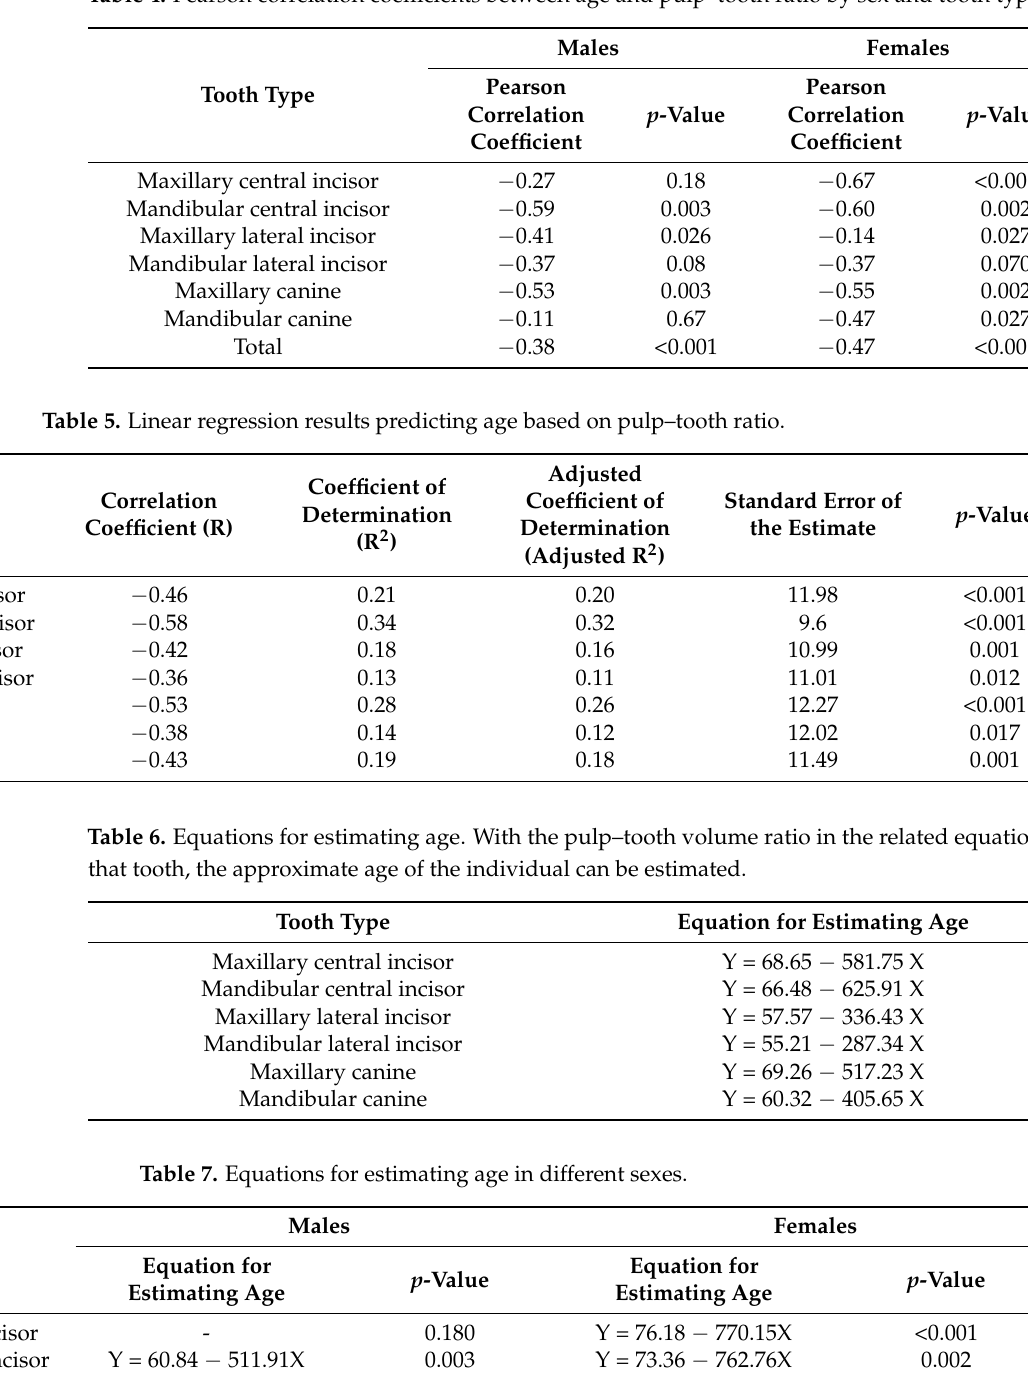
Table 4. Pearson correlation coefficients between age and pulp–tooth ratio by sex and tooth type.